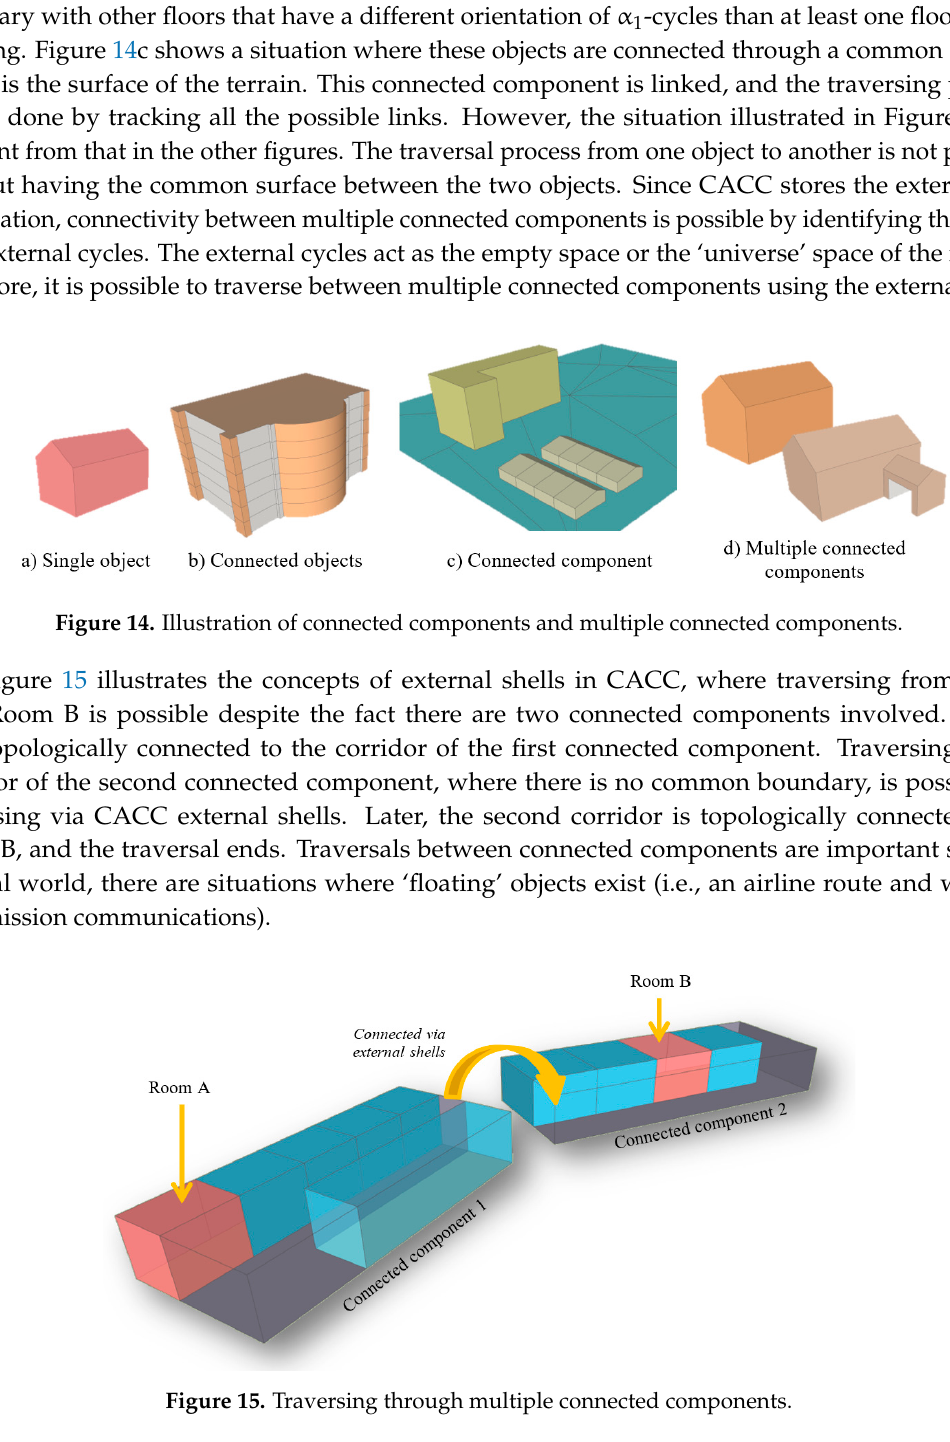
Figure 13: The nearest arc lengths from building A are B, C, and D, in that order.